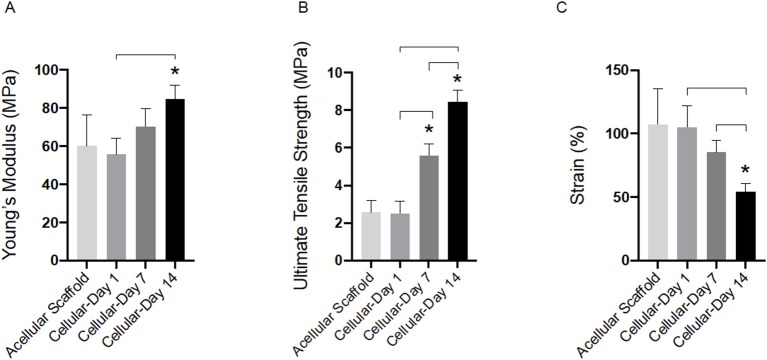
Tensile properties for acellular and cellular aligned electrospun bilayer scaffolds cultured for 1, 7, and 14 days with bovine AF cells; (A) Young's modulus, (B) Ultimate tensile strength, and (C) Percentage strain. Statistical comparison performed with two-way ANOVA and Tukey's post-test (p < 0.05; n = 8). Stars (*) represent statistical significance compared to acellular scaffold; down-caps line represents statistical significance between cellular scaffolds at different time points.